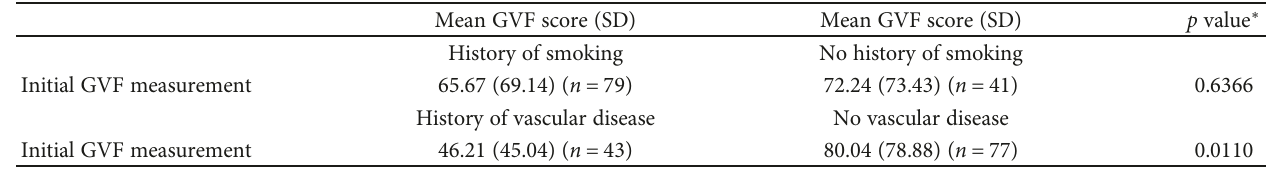
Table 4: Relationship between Goldmann visual fi eld scores and clinical